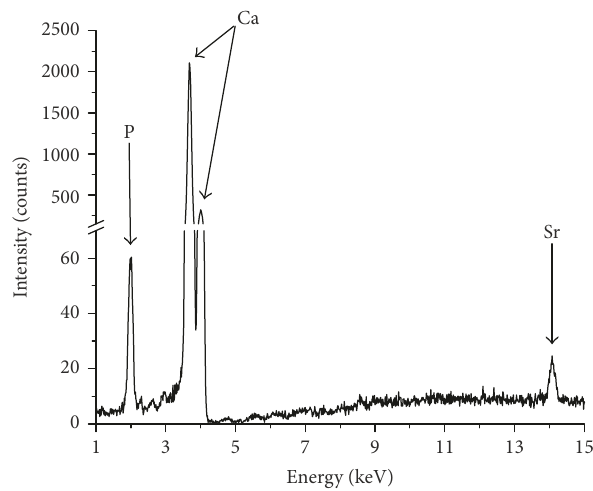
Figure 1: X-ray fluorescence spectrum of tooth enamel.